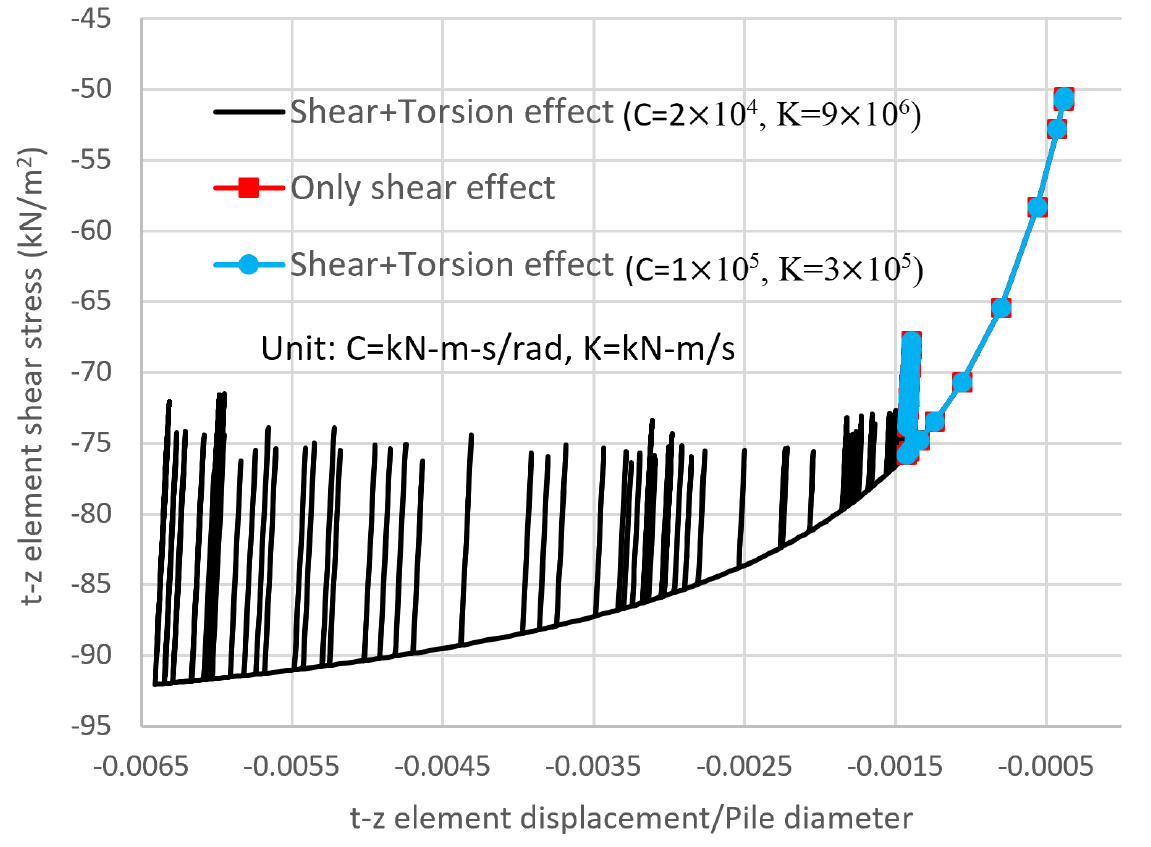
Figure 7. The changes in the curves of shear forces with displacements at the end of 40 m pile for the three cases under a load of DLC 1.1 with an average speed of 11 m/s.